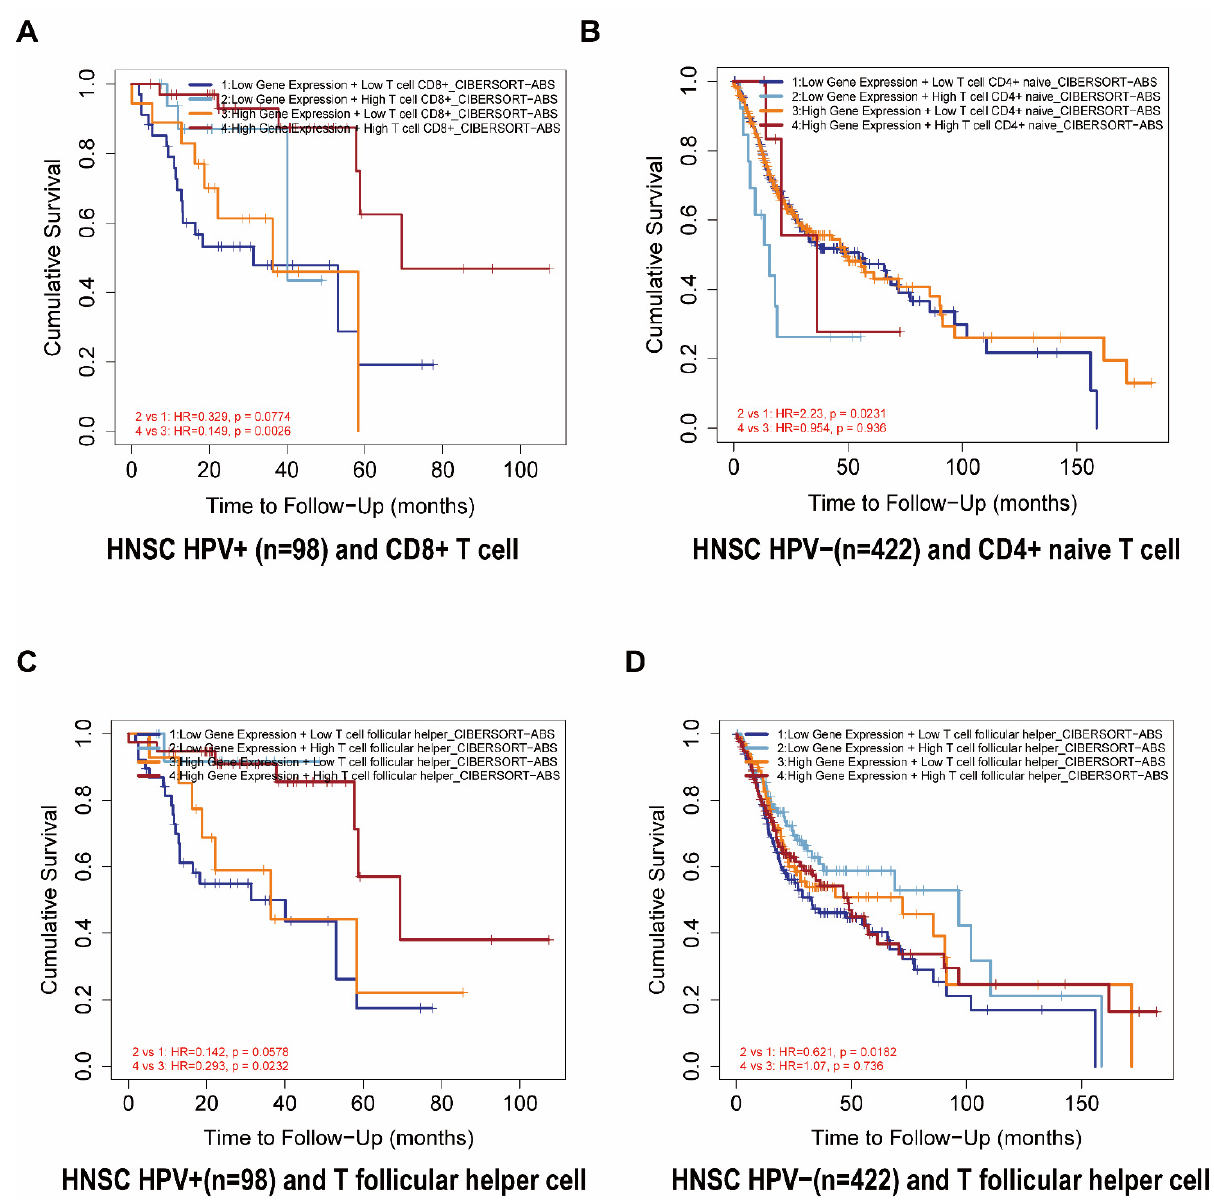
Figure 4. The relationship between FDCSP and immune cells in TCGA-HNSC. ( A – D ) Kaplan–Meier curves for the corresponding immune infiltrates and FDCSP expression in HPV status. (( A ) FDCSP in HPV+ with CD8 + T cells; ( B ) FDCSP in HPV − with CD4 + T cells; ( C ) FDCSP in HPV+ with TFHs; ( D ) FDCSP in HPV − with TFHs) .